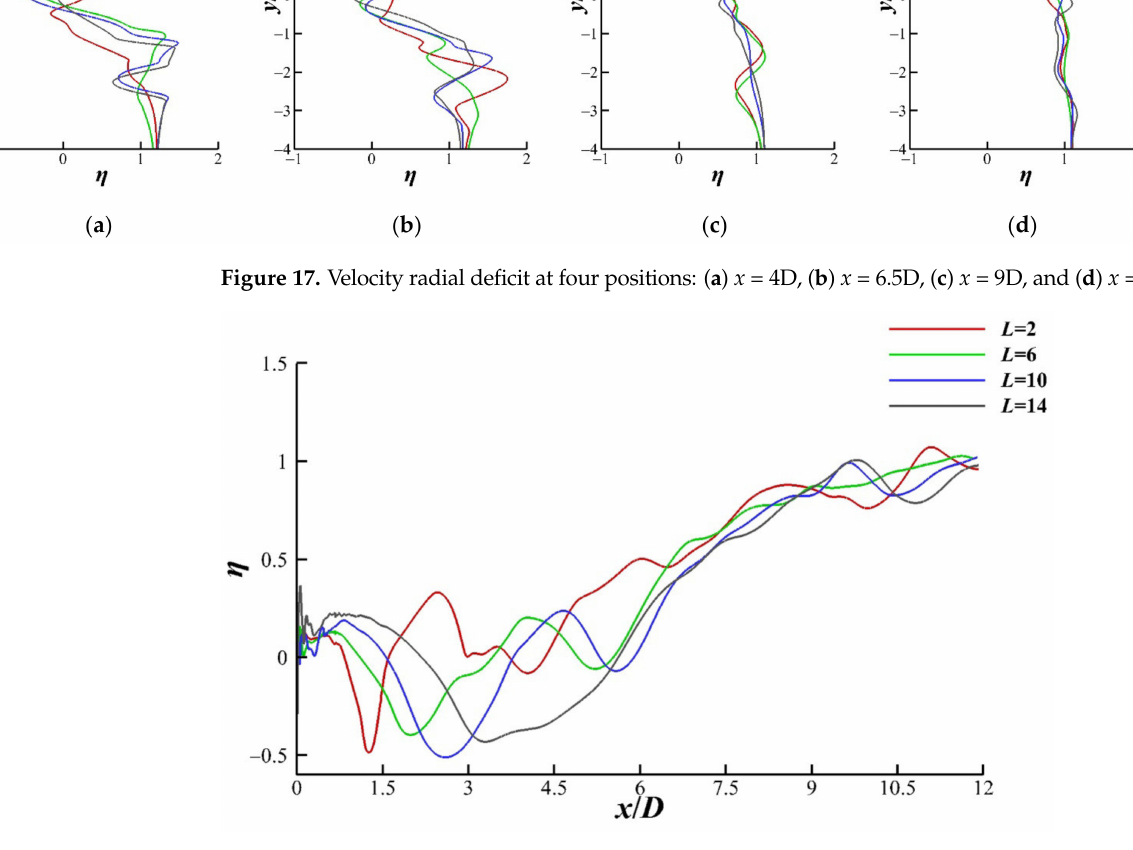
Figure 18. Velocity radial deficit along y =